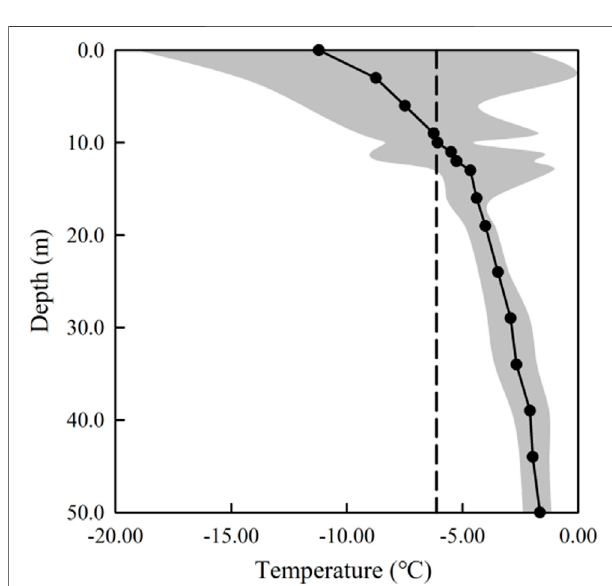
FIGURE 5 | The borehole ice temperatures from a depth of 50 m. The points showed the average ice temperature during January 2010 to October 2011, the shadow showed the fl uctuation ranges of annual ice temperature, and the dashed line is the local average air temperature.